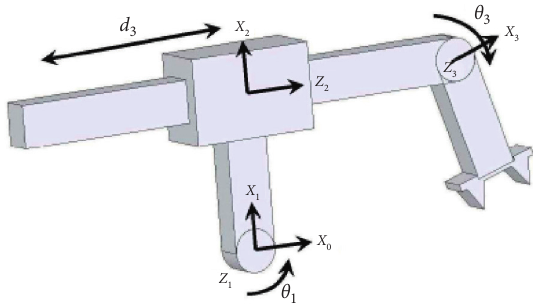
Figure 5: RPR arm